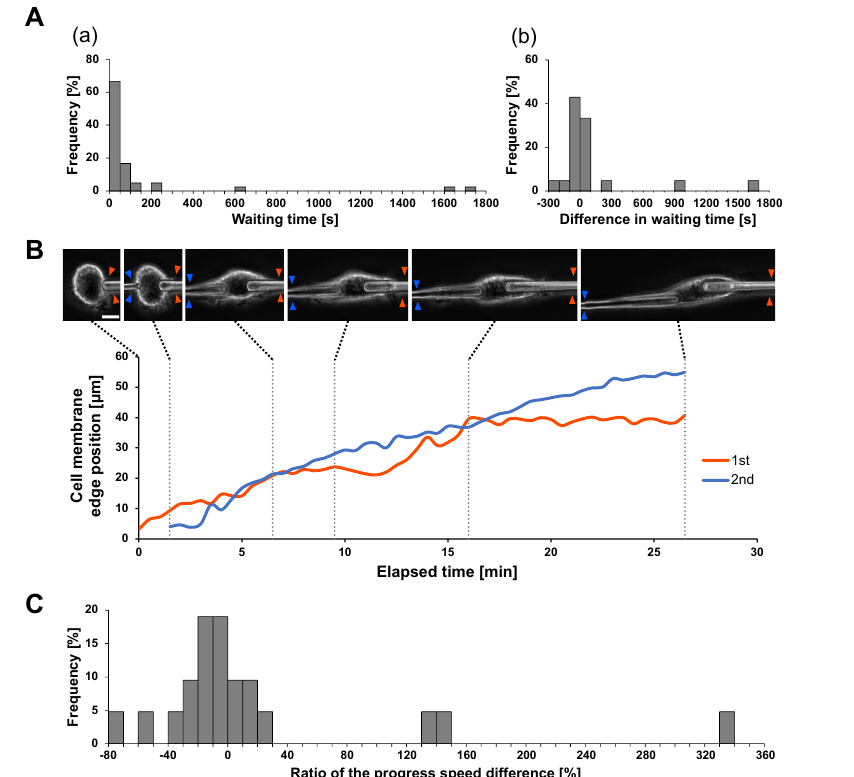
Figure 4. Waiting time from antigen contact to the start of phagocytosis and progress speed in IgG/BSA-coated microneedle phagocytosis. ( A ). Evaluation of waiting time from antigen micronee- dle contact to the start of phagocytosis in two-microneedle phagocytosis (n = 21 samples). ( a ) His- togram of waiting time. The time from microneedle contact to the start of phagocytosis was measured for each of the two needles. ( b ) Difference in waiting time in the first and second needles. ( B ). Typical example of cell membrane progression on the first (red) and second (blue) microneedles in two- microneedle phagocytosis. The edges of the cell membrane on the first and second microneedles are indicated by red and blue arrowheads in the micrographs. Bar: 10µm. ( C ). Evaluation of the differ- ence in the progress speed of the cell membrane on the first and second microneedles. The progress speed was measured for each of the two microneedles, and the ratio of these differences to the progress speed on the first needle, i.e., 100 × ((2nd) − (1st))/(1st), was